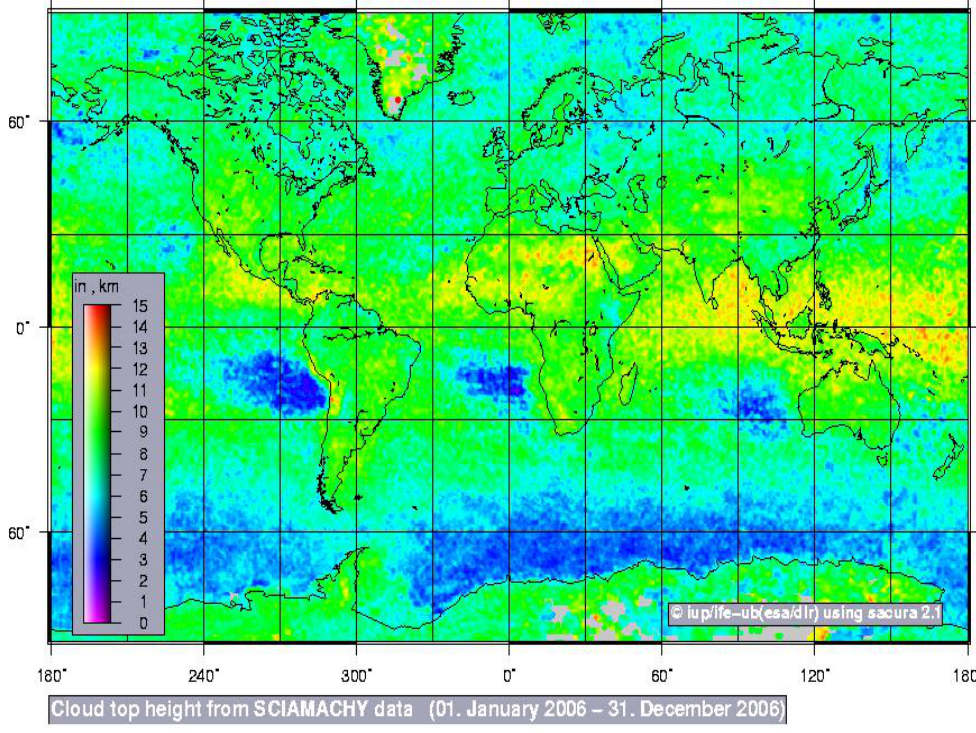
Figure 1. The cloud top height map for year 2006.